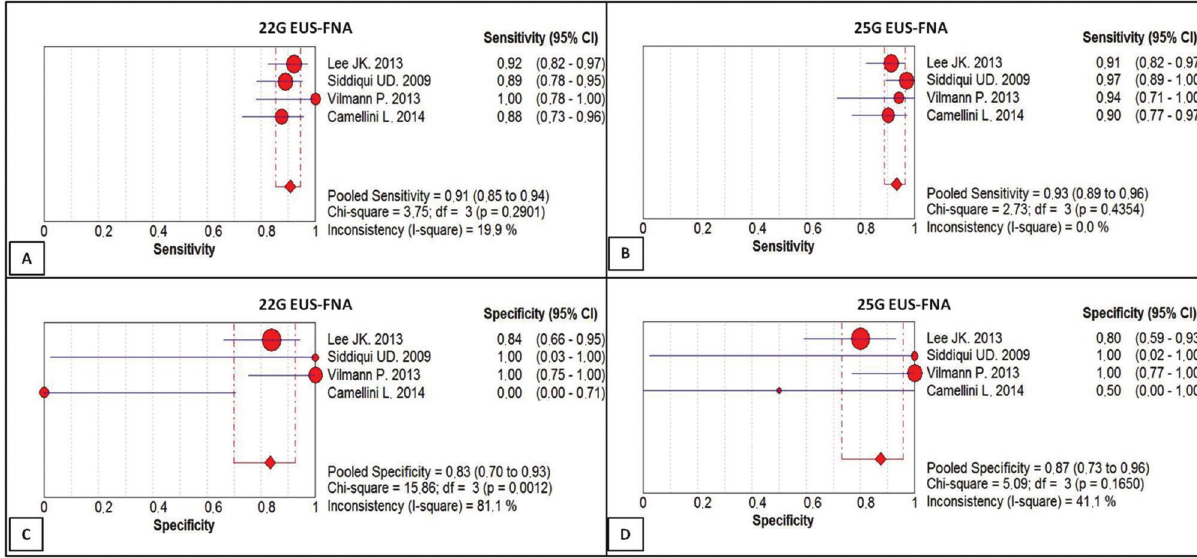
Figure 3 - (A) Sensitivity of EUS-FNA with the 22G needle (91%); (B) Sensitivity of EUS-FNA with the 25G needle (93%); (C) Specificity of EUS-FNA with the 22G needle (83%); (D) Specificity of EUS-FNA with the 25G needle (87%).